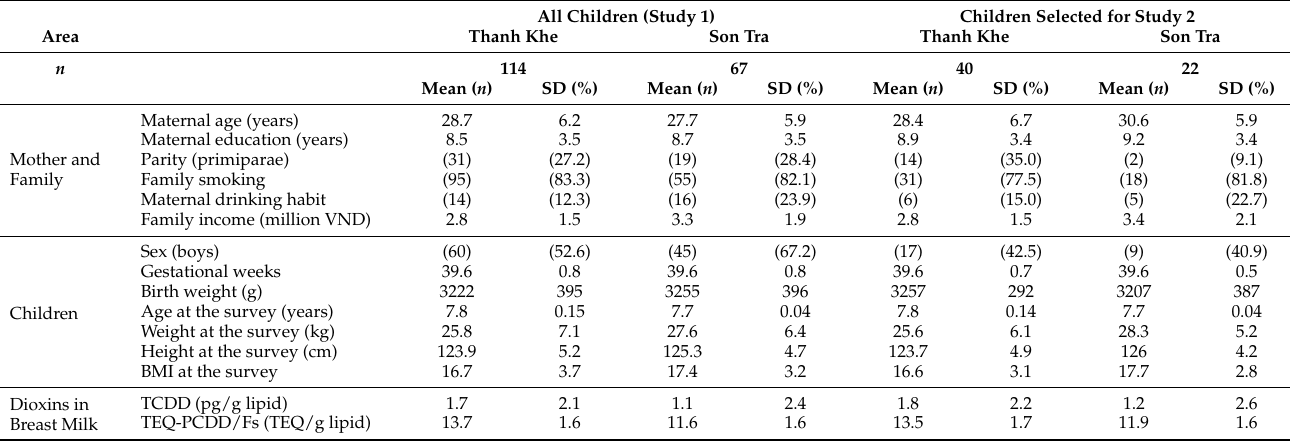
Table 1. Characteristics and dioxin exposure levels of all children who participated in the pre-intervention survey (Study 1) and those of children who were assigned to the intervention study in Thanh Khe (DBB-intervention area) and Son Tra (reference area) (Study